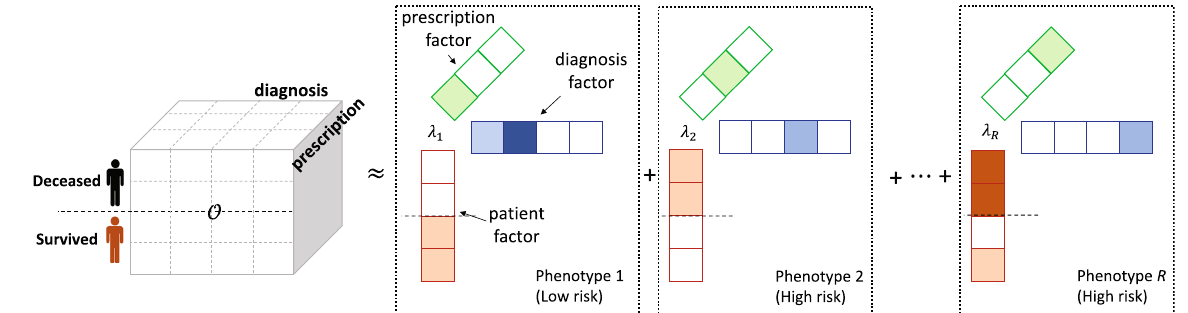
Figure 3. Phenotyping by tensor factorization. Dark shade, light shade, and no shade represents high membership, low membership, and zero membership to the phenotype, respectively. Patients who died have high membership to Phenotype 2 and Phenotype R .